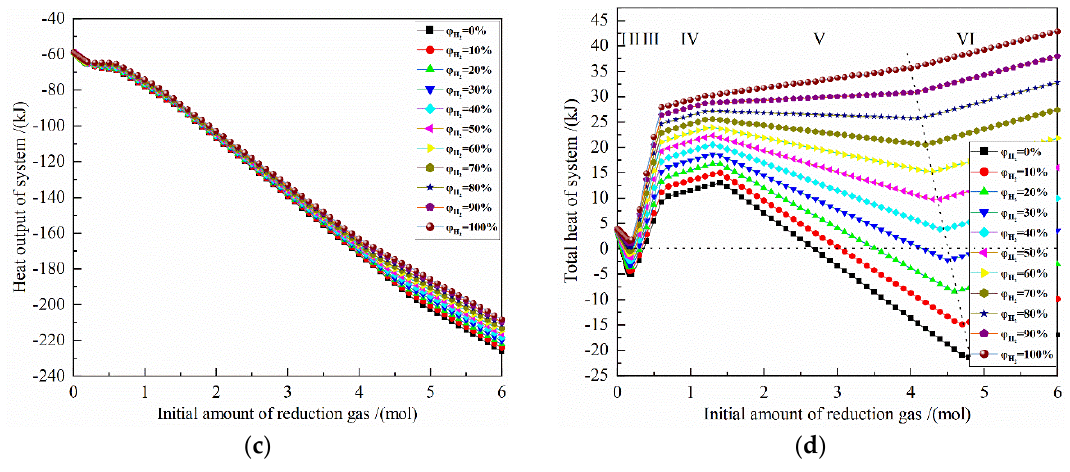
Figure 5. The effect of the initial amount of reduction gas on energy consumption of the reduction of 0.5 mol Fe 2 O 3 at 900 ° С with varied H 2 concentrations: ( a ) reaction heat; ( b ) heat input; ( c ) heat output; ( d ) total heat.